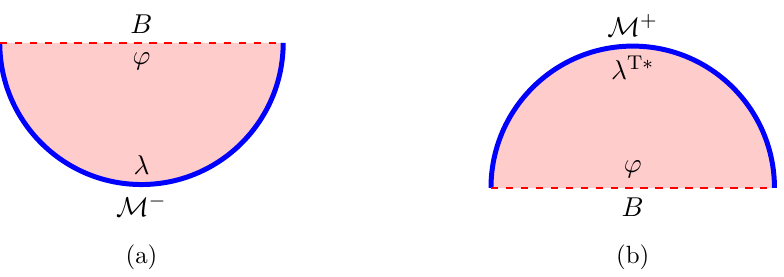
Figure 9. The boundary conditions for the bulk wavefunctionals (a) h ’ j (cid:21) i and (b) h (cid:21) j ’ i . (cid:15) There is another type of Z + C symmetry, distinct from the (cid:12)rst, which acts only 2 on the (cid:12)elds at (cid:22)(cid:6) (cid:6) . It re(cid:13)ects all components of the (cid:12)elds in time, and complex conjugates them, but it does not swap (cid:22)(cid:6) (cid:0) and (cid:22)(cid:6) + . This symmetry is inherited from the (cid:22) T symmetry of the replicated spacetime. All of the (cid:12)elds (cid:30); (cid:14) i under this